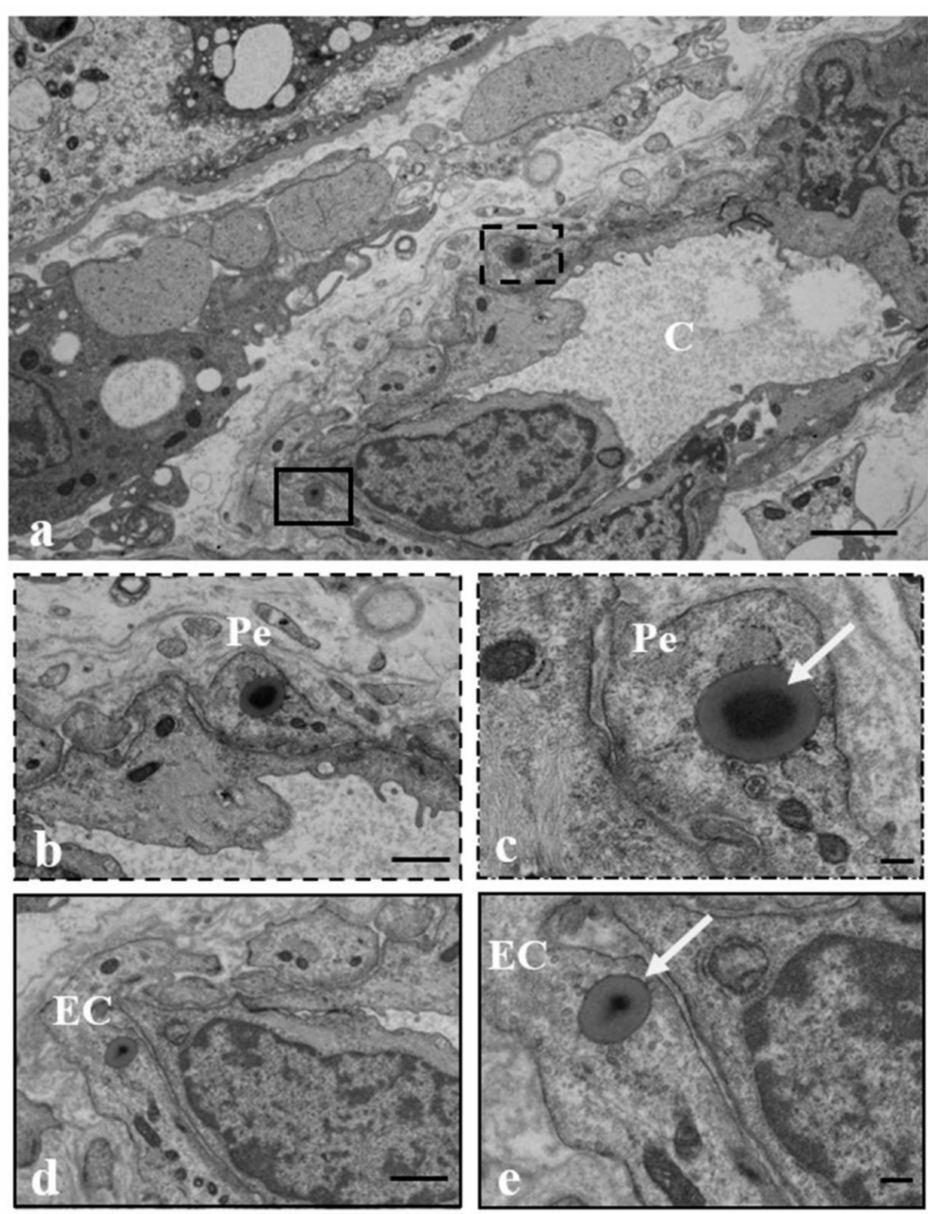
Figure 4. MPs in the fetal microvessels of human placenta. ( a ) Micrographs of a fetal microvessel (C) in which MPs (arrows) are ( b , c ) encapsuled in the cytoplasm of both the pericyte (Pe) that is lining the outer surface of endothelial cells (ECs) surrounding the sinusoid and ( d , e ) the ECs. Bar = 2 µ m ( a ); Bar = 1 µ m ( b , d ); Bar = 200 nm ( c , e